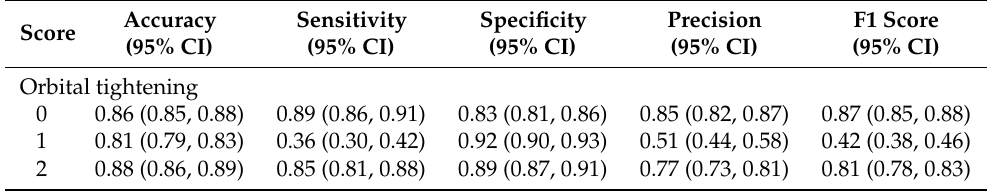
Table 2. DeepMGS performance in the three levels (0, 1, and 2) of each MGS action